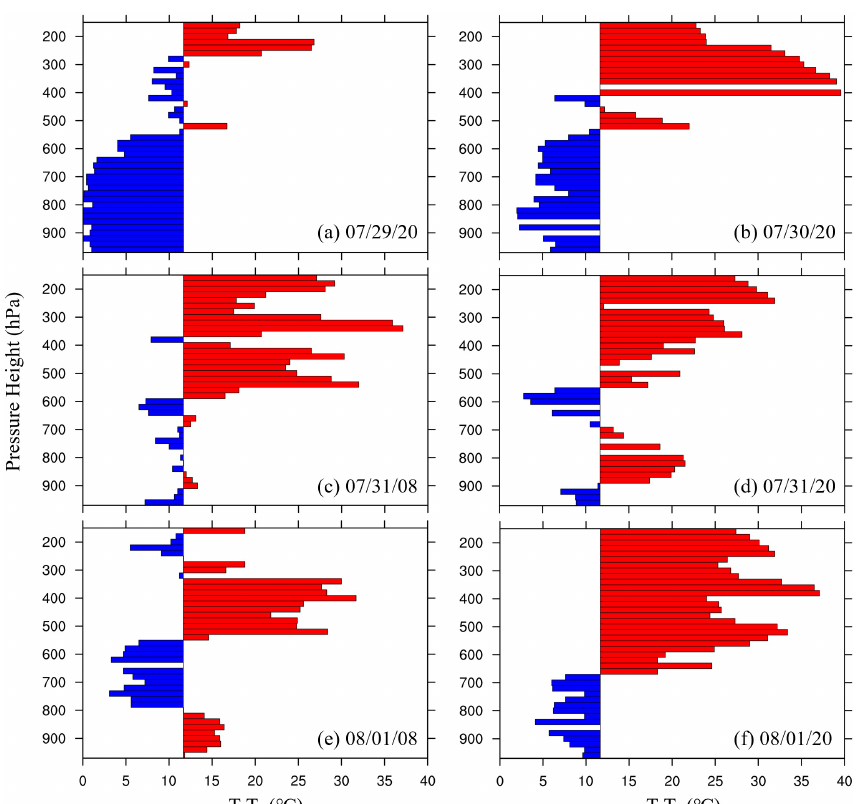
Figure 6. Profiles of dew-point depressions ( T − T d , unit: ◦ C) from Jinan radiosonde observations at (a) 20:00 LST on 29 July, (b) 20:00 LST on 30 July, (c) 08:00 LST, (d) 20:00 LST on 31 July, (e) 08:00 LST 01, and (f) 20:00 LST on 1 August 2021. These times are indicated as month/day/hour at the bottom right corners. The 10d averaged dew-point depressions between the surface and 700hPa are used as the baseline, and positive (negative) departure from the 10d averaged value is shown in red (blue)